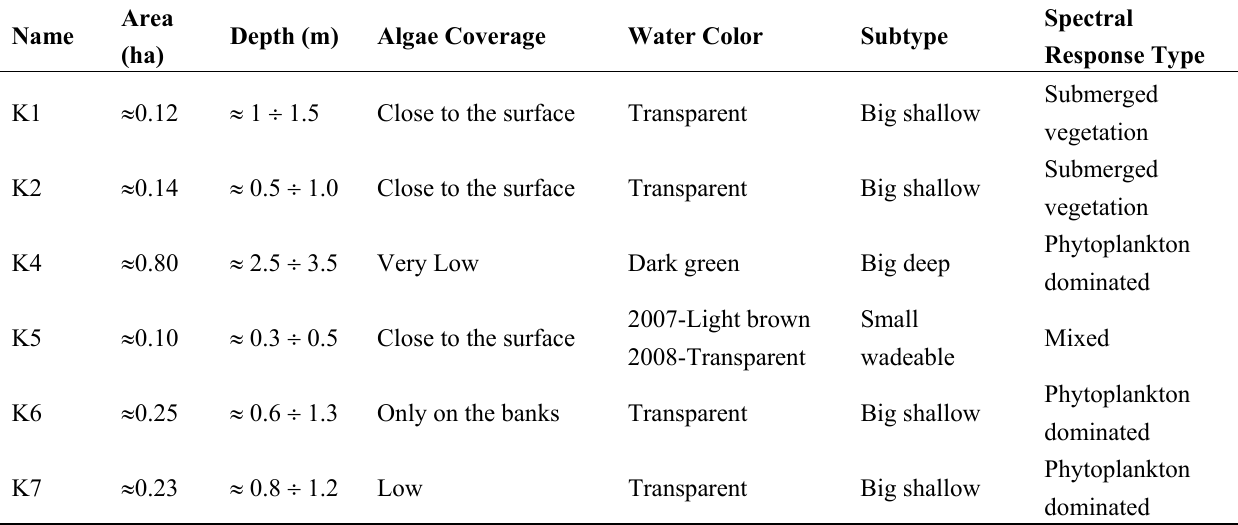
Table 1. Kettle holes’ hydromorphological characteristics and spectral response